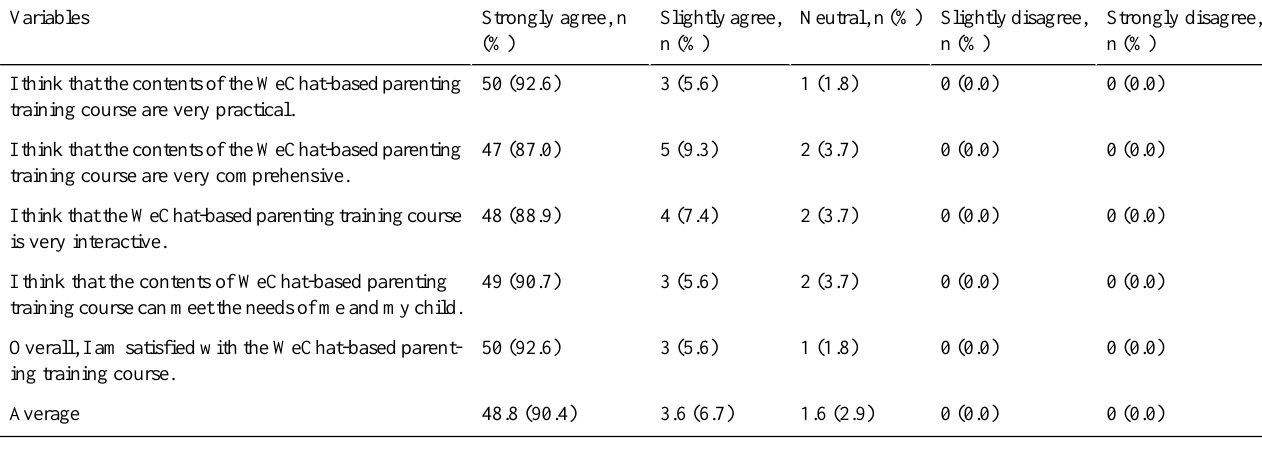
Strongly disagree, n